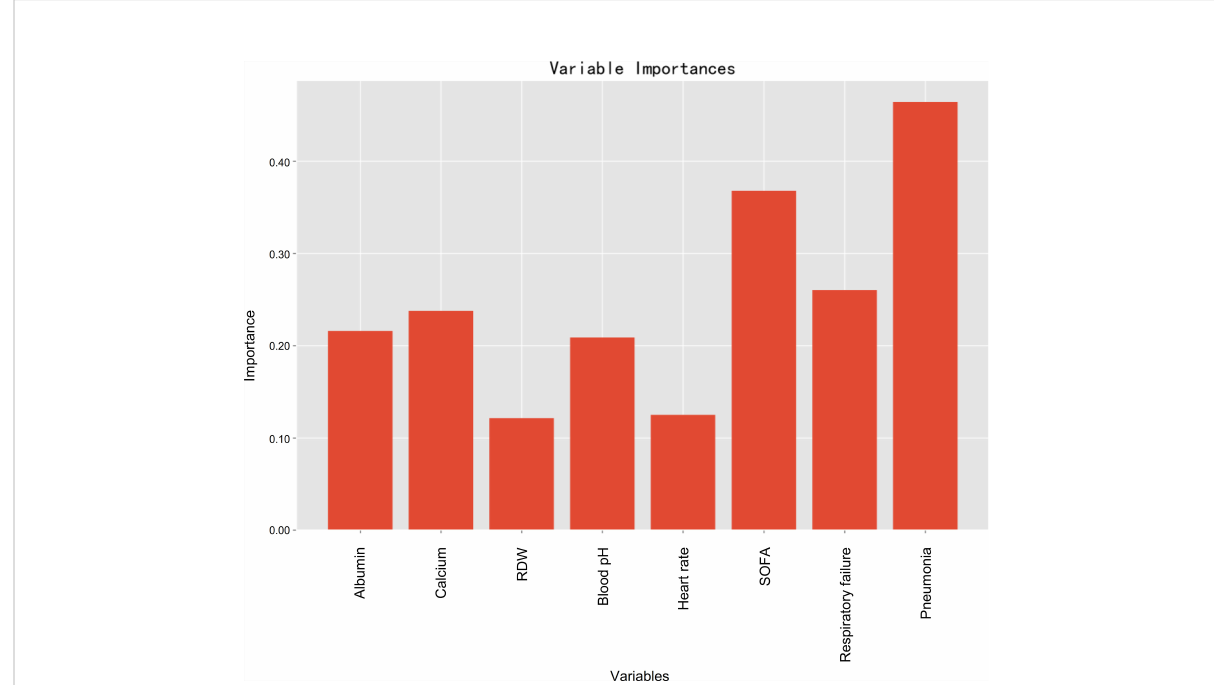
FIGURE 7 Feature importance of model predictors in terms of the random forest algorithm.